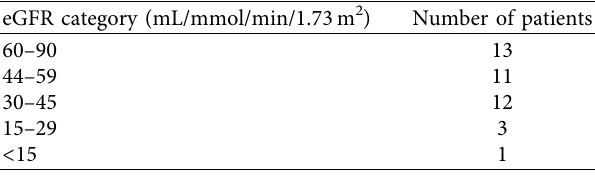
Table 1: eGFR distribution within the sample population in phase II. eGFR category (mL/mmol/min/1.73 m 2